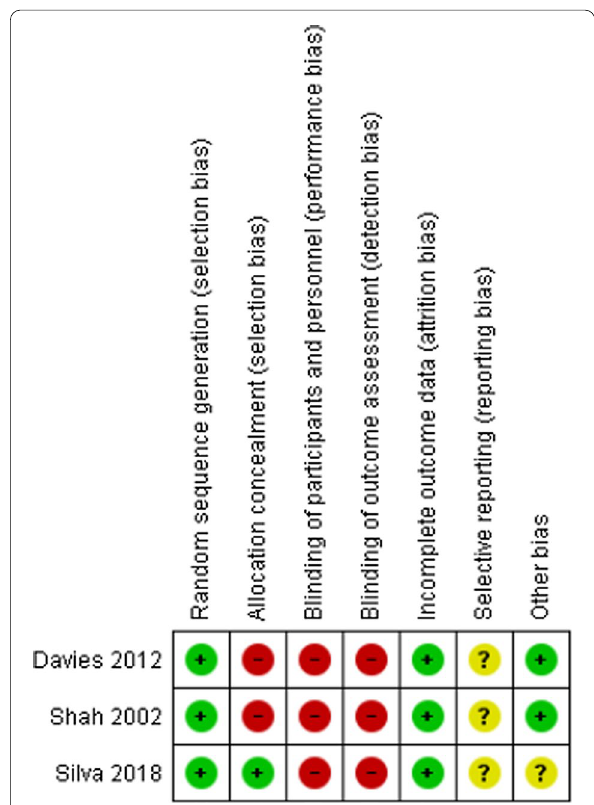
Fig. 2 Risk of bias assessment of included